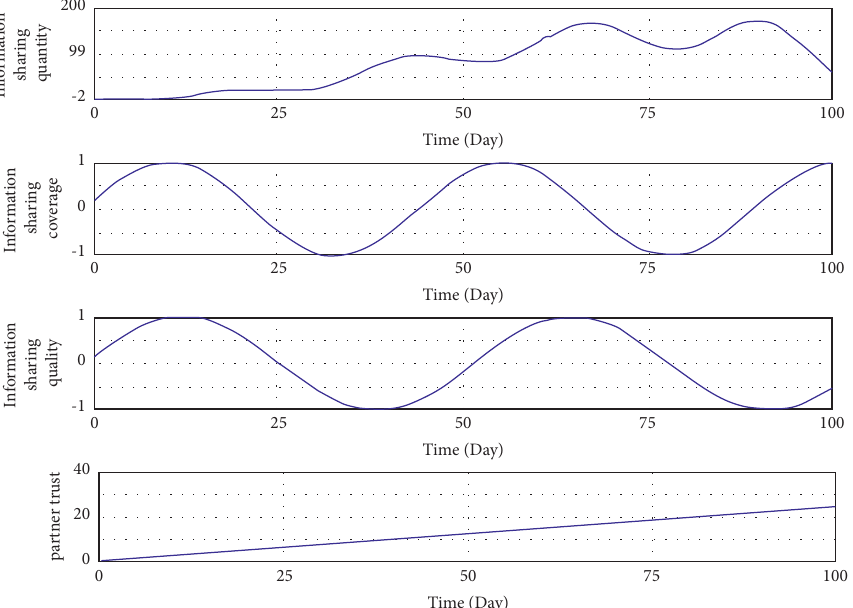
Figure 3: Evolution of IS amount (quantity).